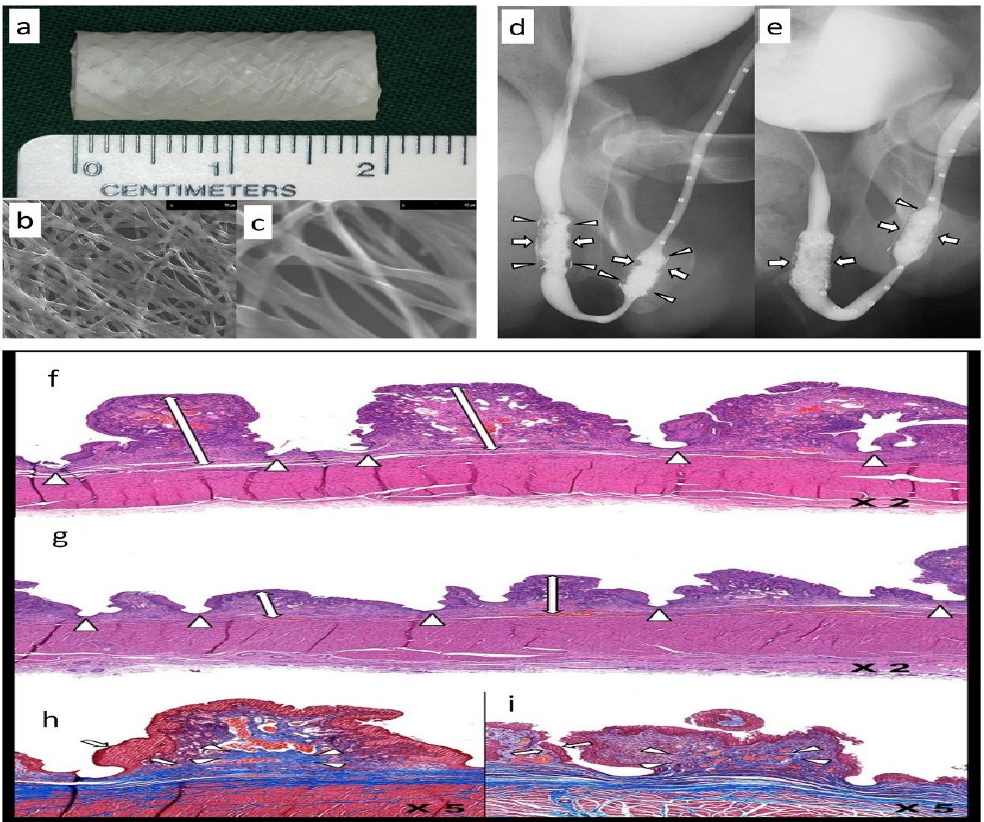
Figure 12. ( a ) shows the nanofiber-coated metallic stent, ( b , c ) show the microstructure of EW-7197 loaded nanofibers. ( d , e ) show the retrograde urethrography images of the drug-free and drug-loaded stent groups. ( f , g ) show the H & E staining images of the drug-free and drug-loaded stent groups. ( h , i ) show Masson’s trichrome staining images of the drug-free and drug-loaded stent groups. Adopted from reference [85].